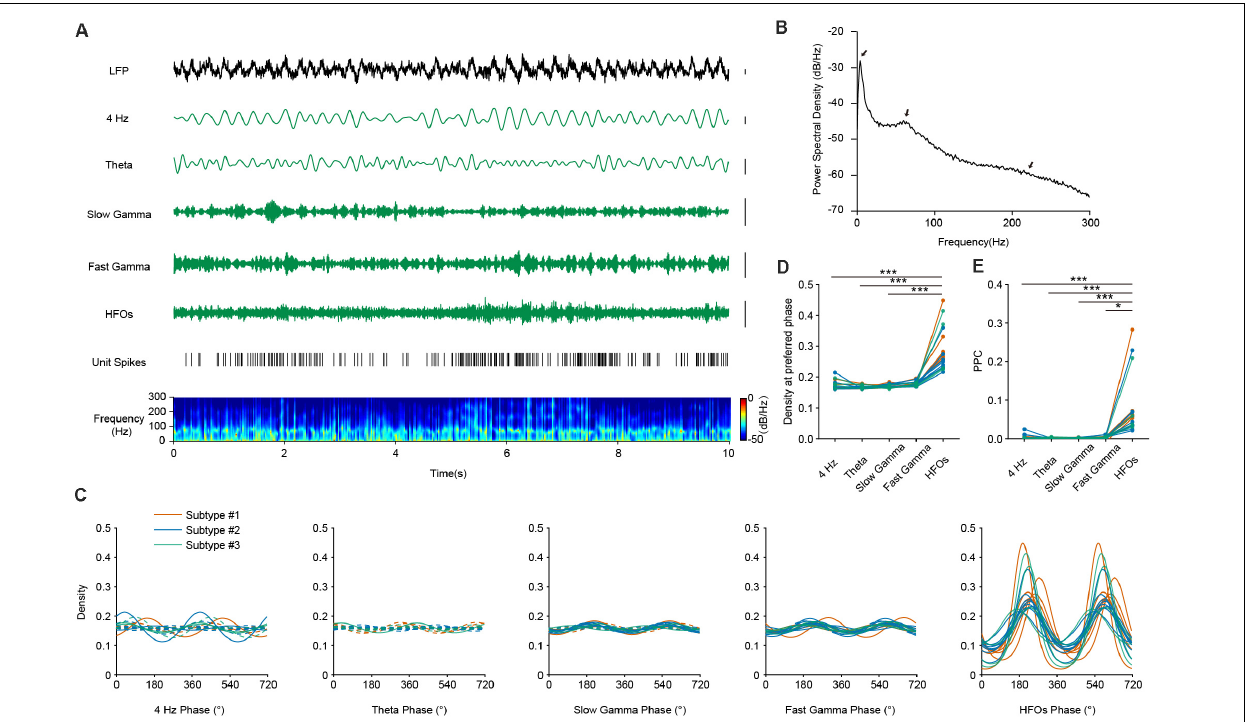
FIGURE 3 | The firing phase-coupling of PFC PV interneurons to LFP HFOs during AW state. (A) Example traces showing PV interneuron spikes and different LFP oscillation components during AW state. From top to bottom, LFP signal recorded in the PFC, cortical 4 Hz oscillation, theta oscillation, slow and fast gamma oscillation, HFOs filtered from LFP, PV interneuron spiking activity (each stick represents one action potential fired by the neuron), and power spectrogram of LFP (10 s of data is shown, scale, 0.1 mV). Note the co-activity of elevated neuronal firing and increased power of HFO components in the power spectrogram (e.g., from 5 to 8 s). (B) Power spectral density during AW state of one example recording. Theta, gamma and HFO components exhibited prominent power (marked by arrows). (C) Firing phase distributions of 3 subtypes of PV interneurons with different oscillation components. Significant phase-locking is shown with solid lines, and non-significant phase-locking shown with dashed lines (Rayleigh’s test, p < 0.001 as significant phase-locking). Each colored line represents one single PV neuron ( n = 18 neurons). PV interneurons fire significantly phase-locked to HFOs during AW state, compared to that with other oscillations. (D) Peak phase coupling density with different oscillations at preferred phase of PV interneuron spikes during AW states (Friedman Test, p = 4.19e-10, Dunn-Bonferroni post hoc , ***, p 4 Hz - HFOs < 0.001, p theta - HFOs < 0.001, p slowgamma - HFOs < 0.001, n = 18 neurons). (E) Comparison of pairwise phase consistency (PPC) analysis. Note that the phasic firing of PV interneurons to HFOs was much more predominant than that to other oscillations during AW state (Friedman Test, p = 7.77e-9, Dunn-Bonferroni post hoc , ***, p 4 Hz - HFOs < 0.001, p theta - HFOs < 0.001, p slowgamma - HFOs < 0.001, *, p fastgamma - HFOs = 0.016, n = 18